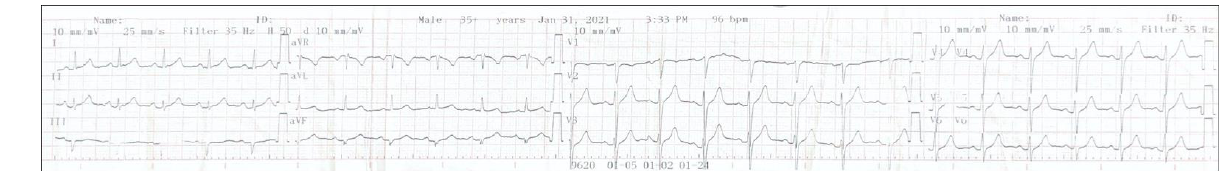
Figure 1. ECG of the patient showing normal pattern.